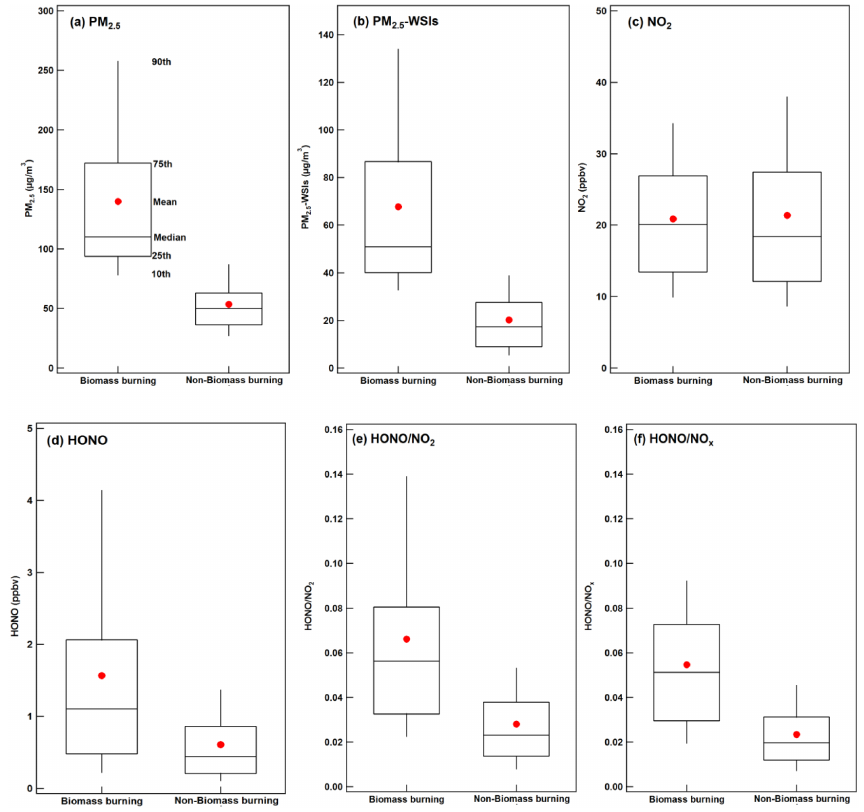
Figure 3. Comparisons between BB periods (203 samples) and non-BB periods (1122 samples) of (a) PM 2 . 5 concentrations, (b) concentra- tions of organic matter in PM 2 . 5 (estimated by PM 2 . 5 -WSIs), (c) NO 2 concentrations, (d) HONO concentrations, (e) HONO to NO 2 ratio and (f) HONO to NO x ratio. There are statistically significant differences for all the data pairs ( p (cid:28) 0 . 01) except NO 2 ( p = 0 . 51).